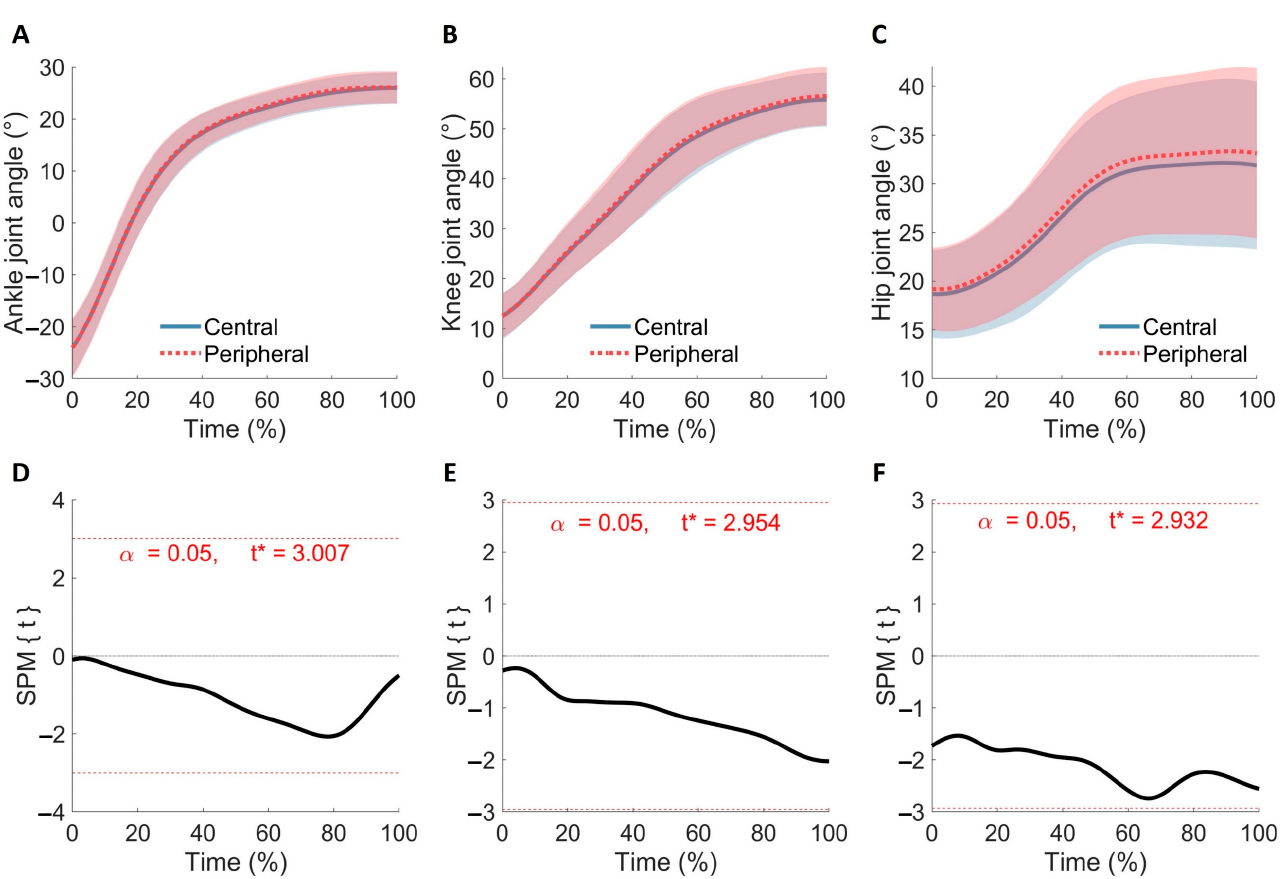
Figure 1. Sagittal plane joint angle. Descriptive statistics for each condition (mean ± 1 standard deviation error cloud) for the ankle ( A ), knee ( B ), and hip ( C ) joint angles. Time was determined from initial contact (0%) to peak knee flexion (100%). The black line is the t-value of each time point for the ankle ( D ), knee ( E ), and hip ( F ) joint angles. The dotted redline is the threshold of significance. No significant difference was observed in the sagittal plane joint angle between the landing